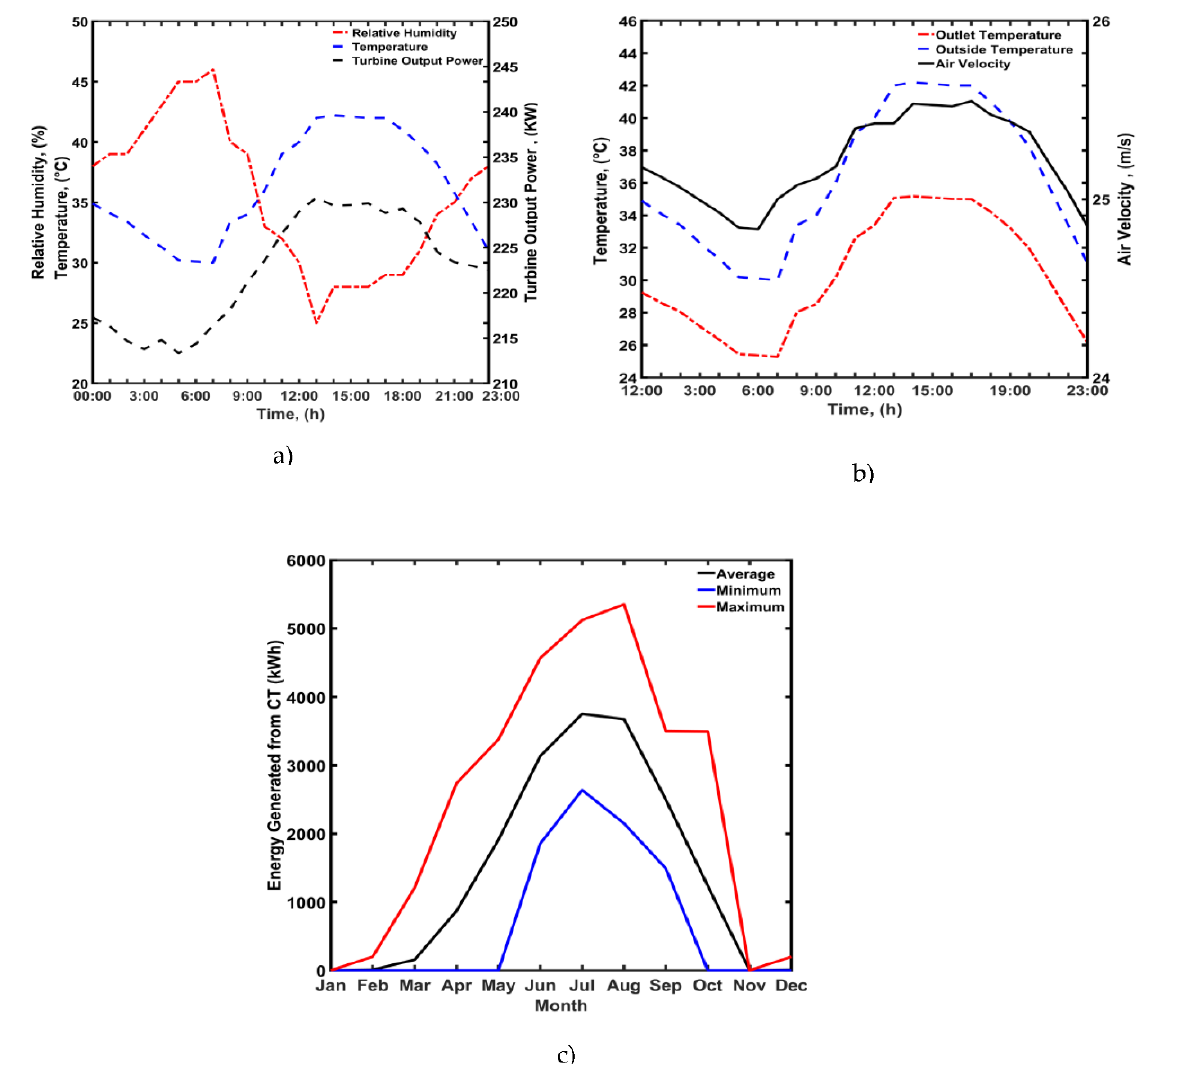
Figure 6. ( a ) Effect of the outside temperature profiles, relative humidity on the performance of the CT, ( b ) the temperature profiles of the outside and the velocity of the water vapor during the CT mode, ( c ) The average daily cumulative energy produced by the CT mode. The data presented were taken on 30 July.